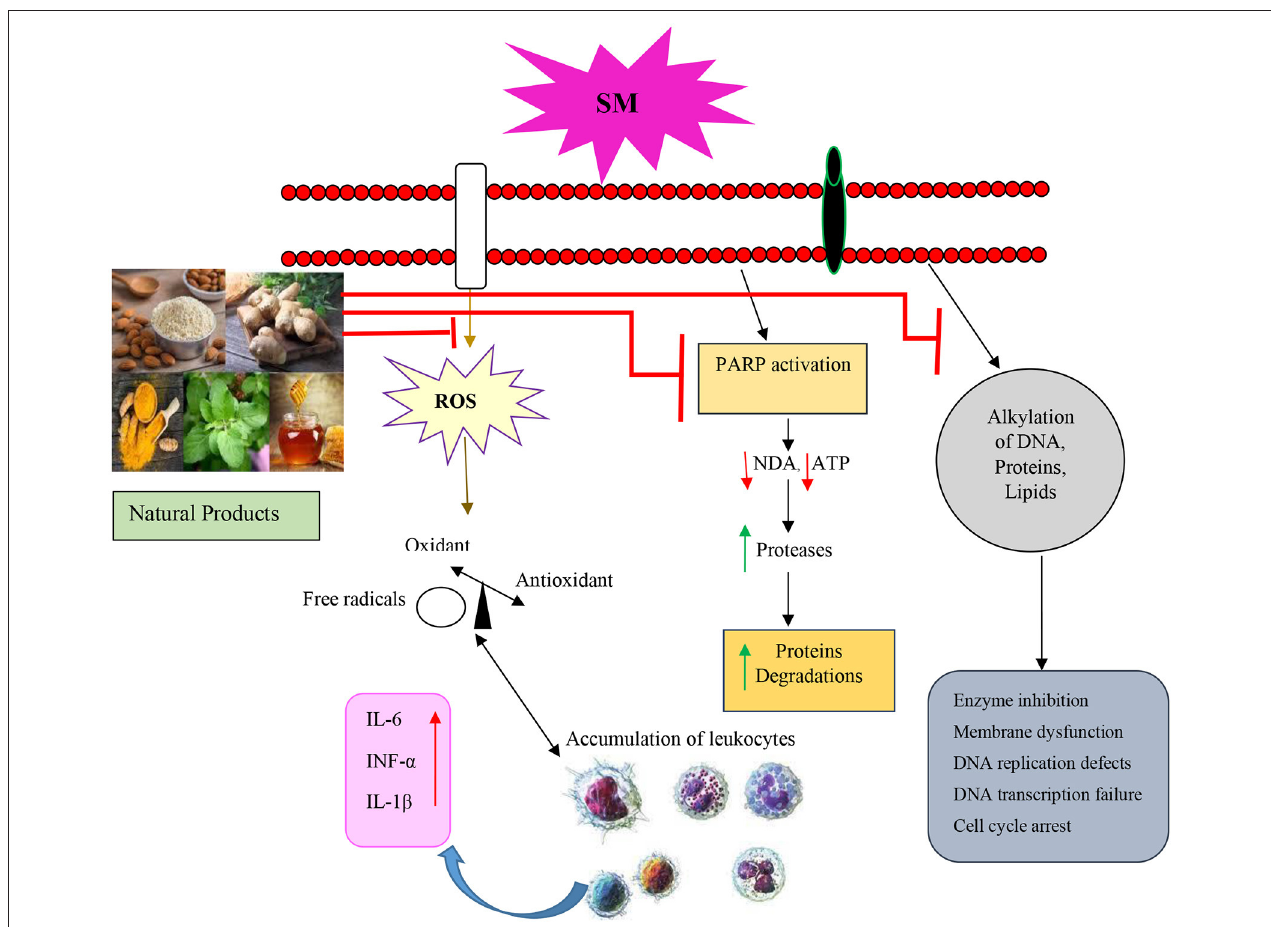
FIGURE 5 | Molecular mechanism of SM-induced toxicity of the relevant studies. SM, Sulfur mustard; ROS, Reactive oxygen species; PARP, Poly (ADP-ribose) polymerase; IL, Interleukin; TNF α , Tumor necrosis factor- α .